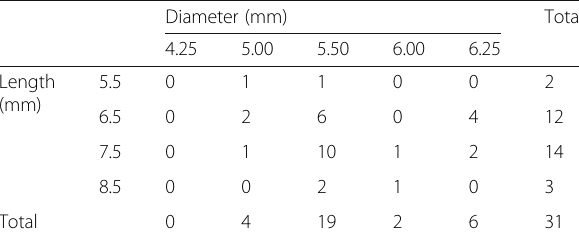
Table 2 Length and diameter of the dental implants in the control group